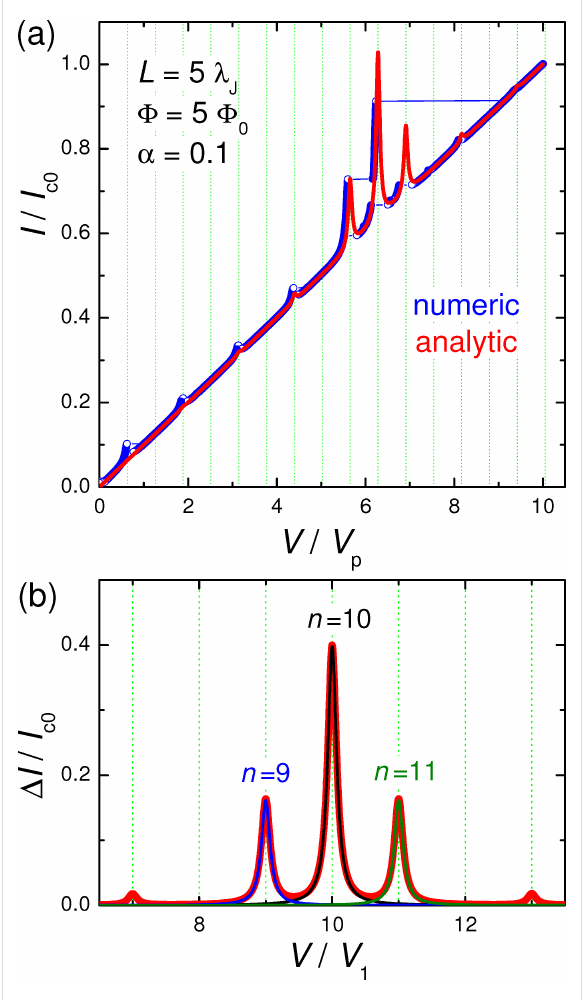
Figure 2: (a) Simulated current–voltage characteristics of a junction with L = 5 λ J , Φ / Φ 0 = 5 and α = 0.1. Blue symbols represent the full numeric solution of the sine-Gordon equation (up and down current sweep). The red line represents the approximate (perturbative) analyt- ic solution, I = V / R QP + Δ I . (b) Excess dc current, Δ I ( V ), at Fiske steps. The thick red line represents the multimode analytic solution, Equation 24. Thin blue, black, and olive lines show single-mode solu- tions for n = 9, 10, and 11, respectively. Vertical grid lines in (a) and (b) mark Fiske step voltages. Voltages are normalized by (a) the plasma frequency voltage, V p , and (b) the lowest Fiske step voltage, V 1